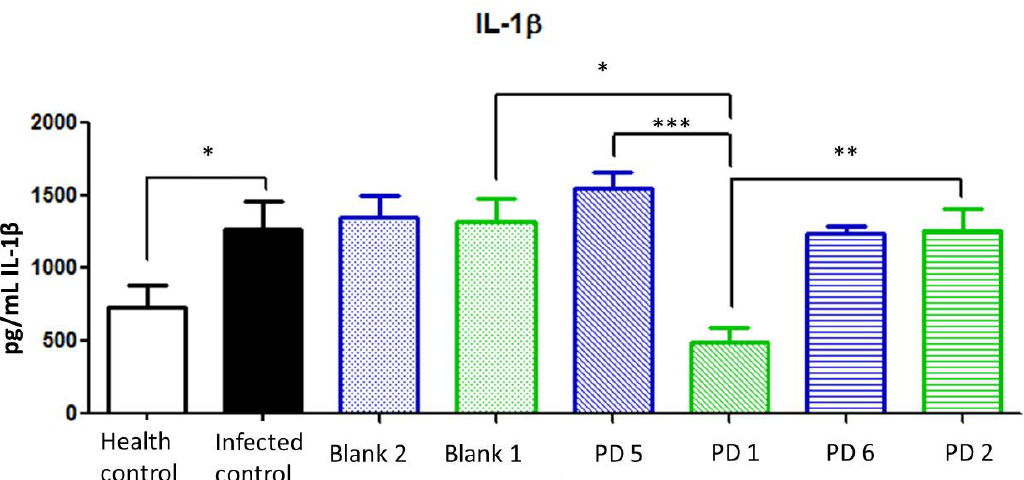
Figure 15. Interleukin (IL)-1 β expression (pg/mL) in the stomach after different treatments and controls. Blank 1: Mucolast ® , Blank 2: PBS. PD1: Amox 89.4 mg/kg/day, Clar 44.7 mg/kg/day in Mucolast ® . PD2: Amox 44.7 mg/kg/day, Clar 22.35 mg/kg/day in Mucolast ® . PD5: Amox 89.4 mg/kg/day, Clar 44.7 mg/kg/day in PBS. PD6: Amox 44.7 mg/kg/day, Clar 22.35 mg/kg/day in PBS. * Statistical differences at 0.05, ** statistical differences at 0.01, and *** statistical differences at 0.001.